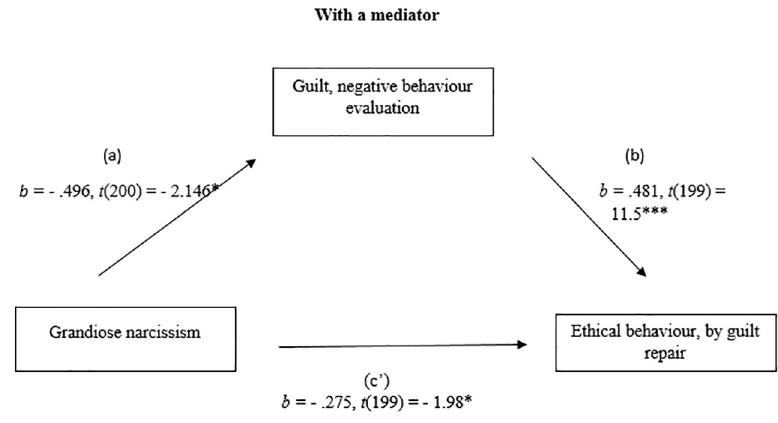
Figure 2. Mediation Analysis: With a mediator. * p < .05. ** p < .01. *** p < .001.